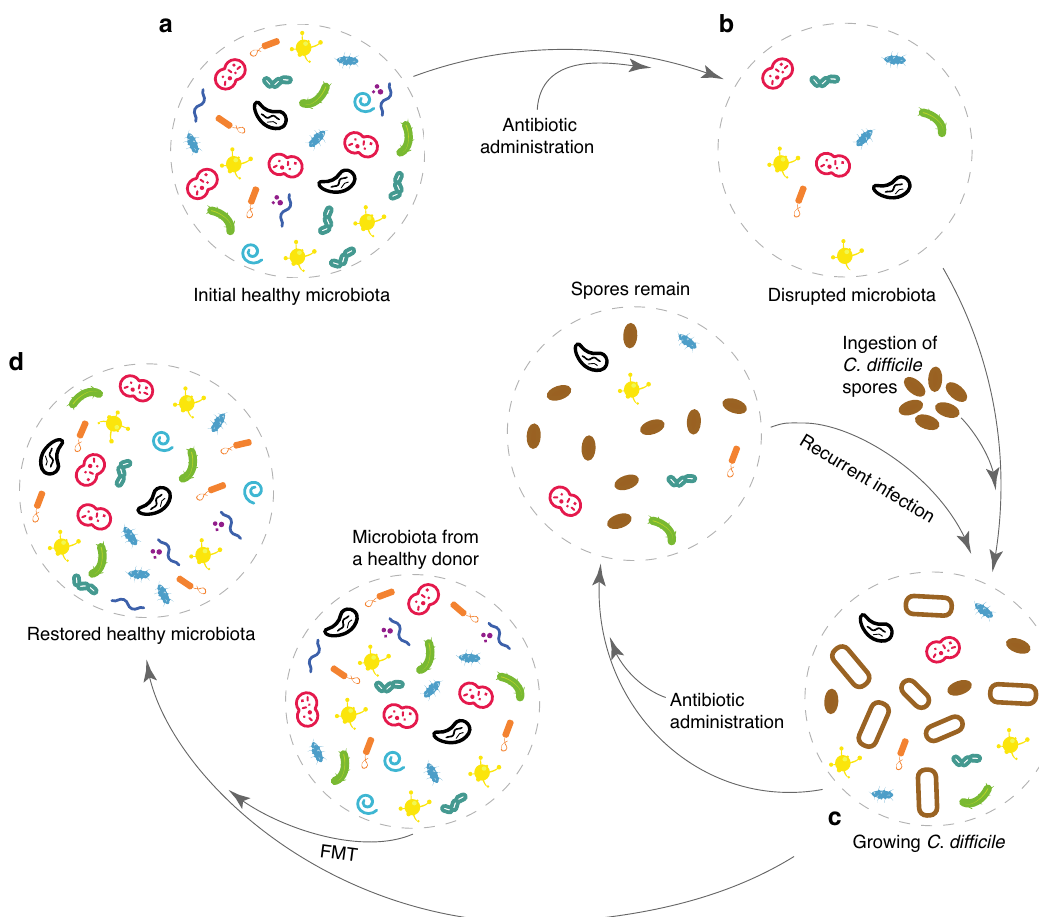
Fig. 1 Fecal microbiota transplantation (FMT) aims to restore a healthy gut microbiota. a In an initial healthy gut, the microbial community typically contains many different taxa and displays very high taxonomic and functional diversity. Most of those taxa are benign. Some of them can even keep out opportunistic pathogens such as C. dif fi cile . b Antibiotic administration leads to low taxonomic diversity and to a disrupted gut microbiota, which allows colonization by C. dif fi cile . c C. dif fi cile spores are typically ingested following contact with contaminated biotic or abiotic surfaces, then germinate in the gut to a vegetative cell-type and produce potent gut-damaging toxins during a late growth stage. This leads the development of C. dif fi cile infection